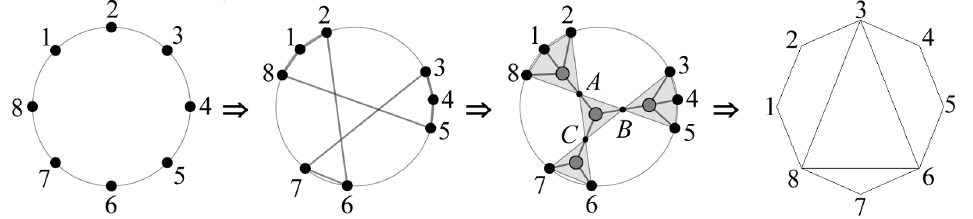
Figure 2. Step by step procedure to draw the mutual partial triangulation for (1 , 2 , 3 , 4 , 5 , 6 , 7 , 8 | 8 , 1 , 2 , 6 , 7 , 3 , 4 , 5)